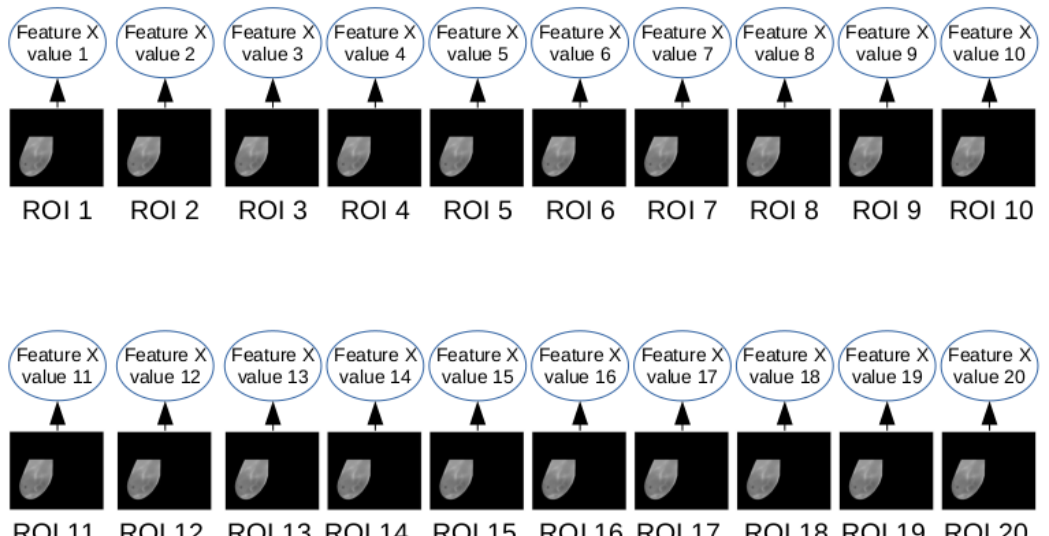
Figure 7. Representation of features based on an individual